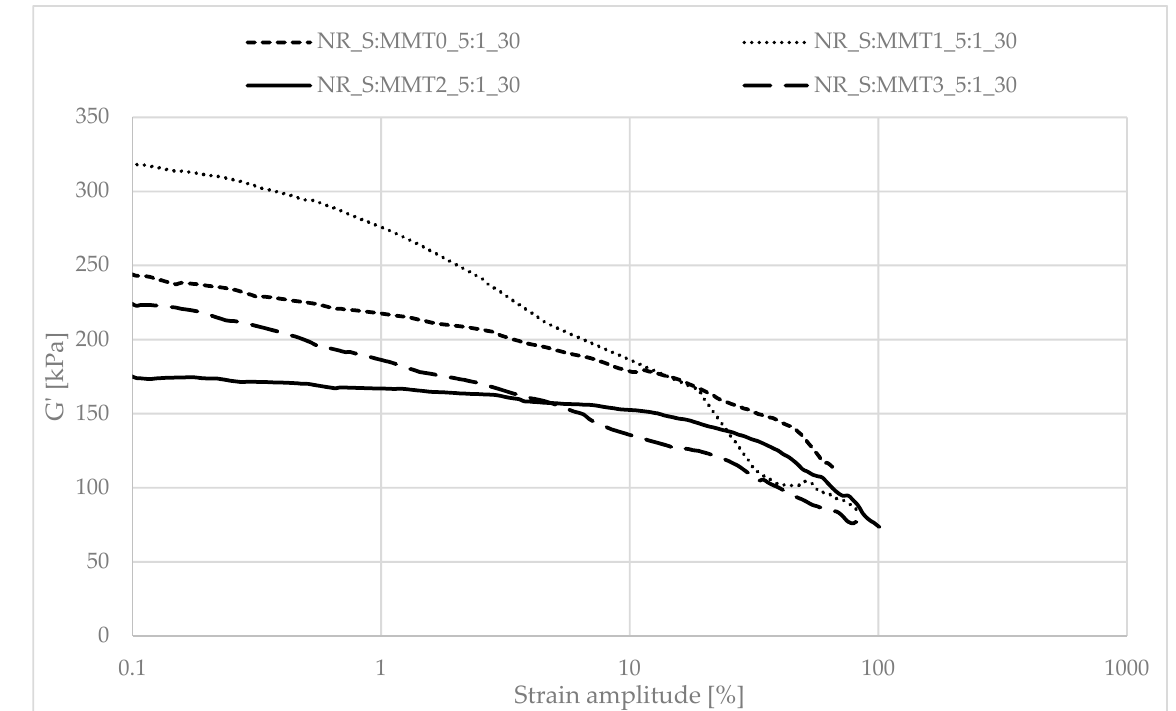
Figure 12. Dependence of the storage module as a function of the strain amplitude for natural rubber composites filled with straw:montmorillonite filler (30 phr), 5:1 ratio.